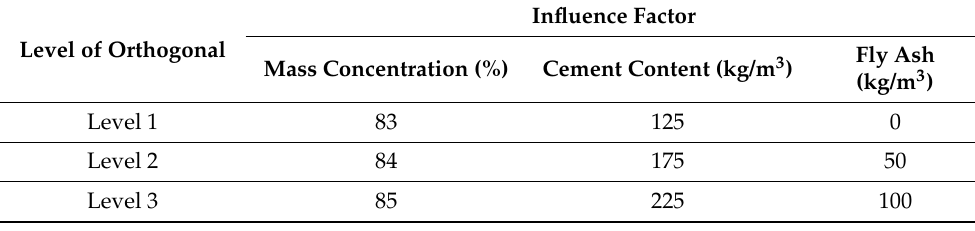
Table 3. Mechanical properties of SL cement.